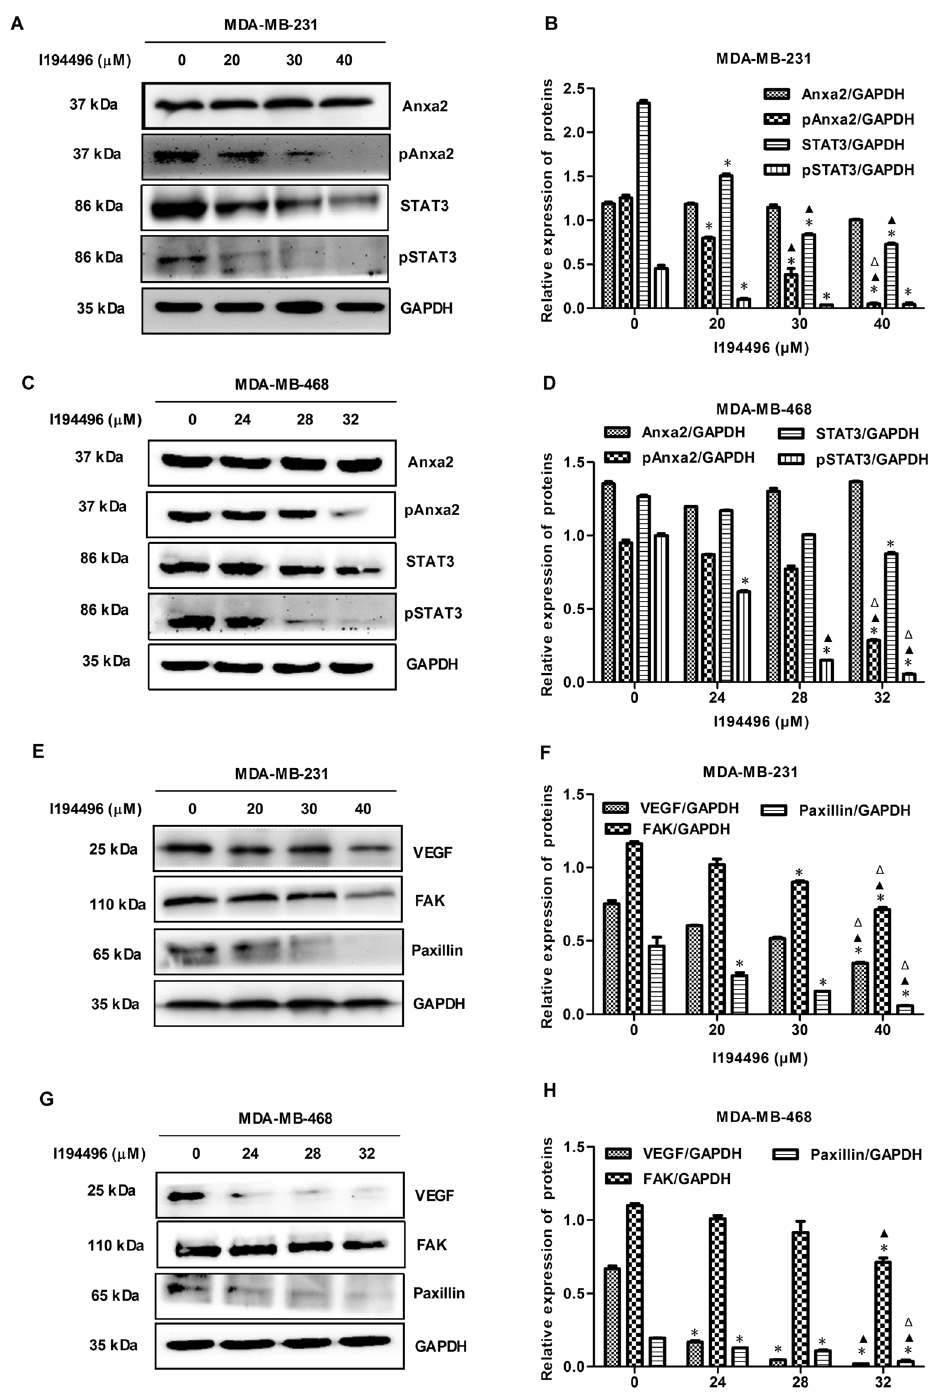
Figure 6. I194496 inhibits the Anxa2/STAT3 and VEGF/FAK/Paxillin signalling pathways in human TNBC cells. ( A , B ) The effect of I194496 on Anxa2/STAT3 pathway in MDA-MB-231 cells. * P < 0.05 vs 0 μM I194496 group. ▲ P < 0.05 vs 20 μM I194496 group. Δ P < 0.05 vs 30 μM I194496 group. ( C , D ) The effect of I194496 on Anxa2/STAT3 pathway in MDA-MB-468 cells. * P < 0.05 vs 0 μM I194496 group. ▲ P < 0.05 vs 24 μM I194496 group. Δ P < 0.05 vs 28 μM I194496 group. ( E , F ) The effect of I194496 on VEGF/FAK/Paxillin signaling pathway in MDA-MB-231 cells. * P < 0.05 vs 0 μM I194496 group. ▲ P < 0.05 vs 20 μM I194496 group. Δ P < 0.05 vs 30 μM I194496 group. ( G , H ) The effect of I194496 on VEGF/FAK/Paxillin signaling pathway in MDA-MB-468 cells. * P < 0.05 vs 0 μM I194496 group. ▲ P < 0.05 vs 24 μM I194496 group. Δ P < 0.05 vs 28 μM I194496